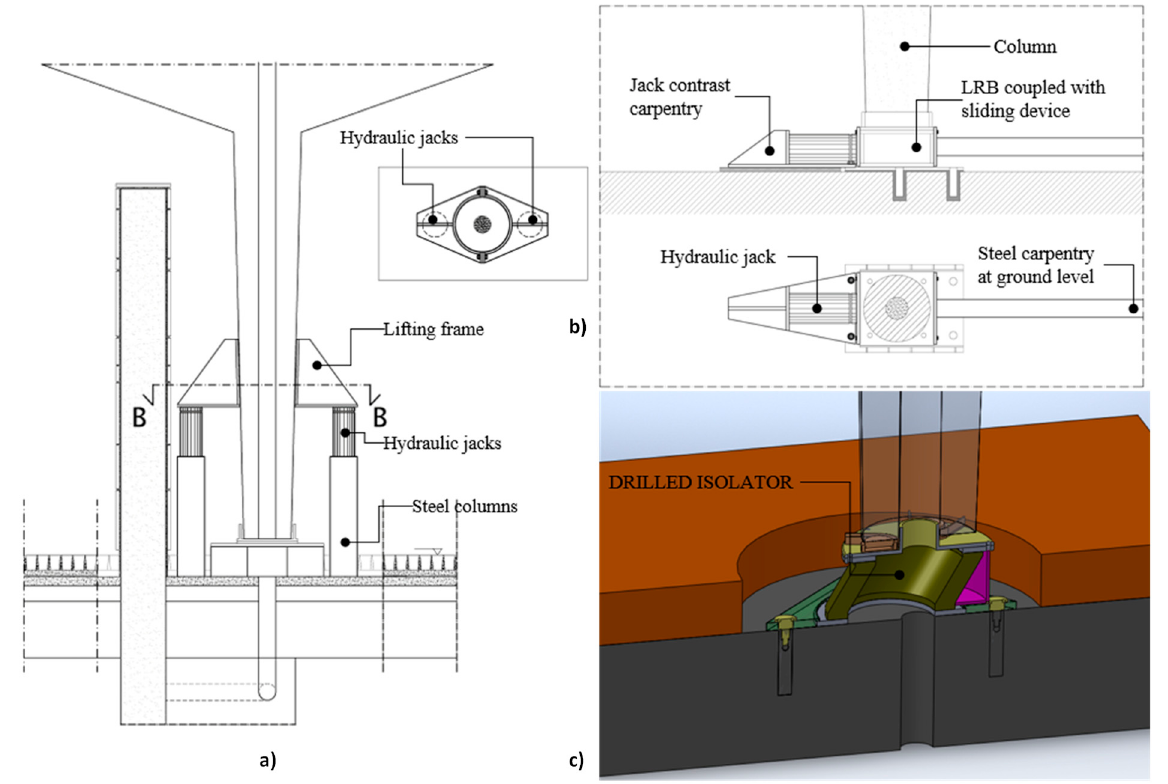
Figure 7. Feasibility study and first proposals of technical solutions: ( a ) lifting system to cut the columns, ( b ) thrusting system, ( c ) drilled Lead Rubber Bearing (LRB) isolator to house the sewage duct.